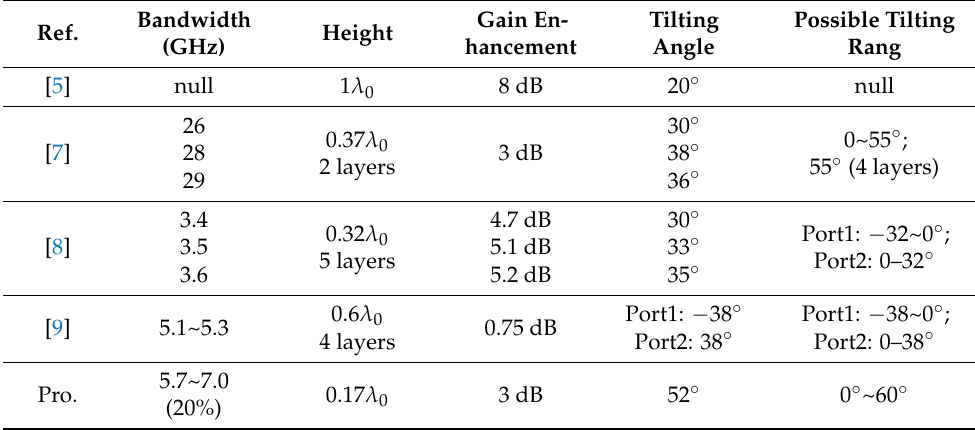
Table 1. Table of performance comparison between the proposed antennas and previous works.